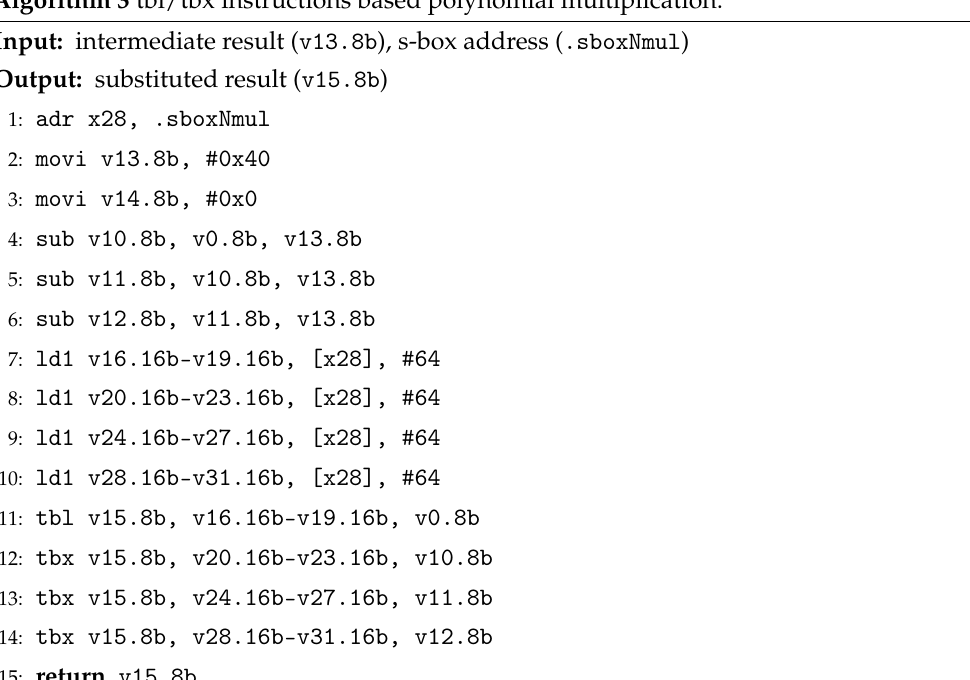
Algorithm 3 tbl/tbx instructions based polynomial multiplication.